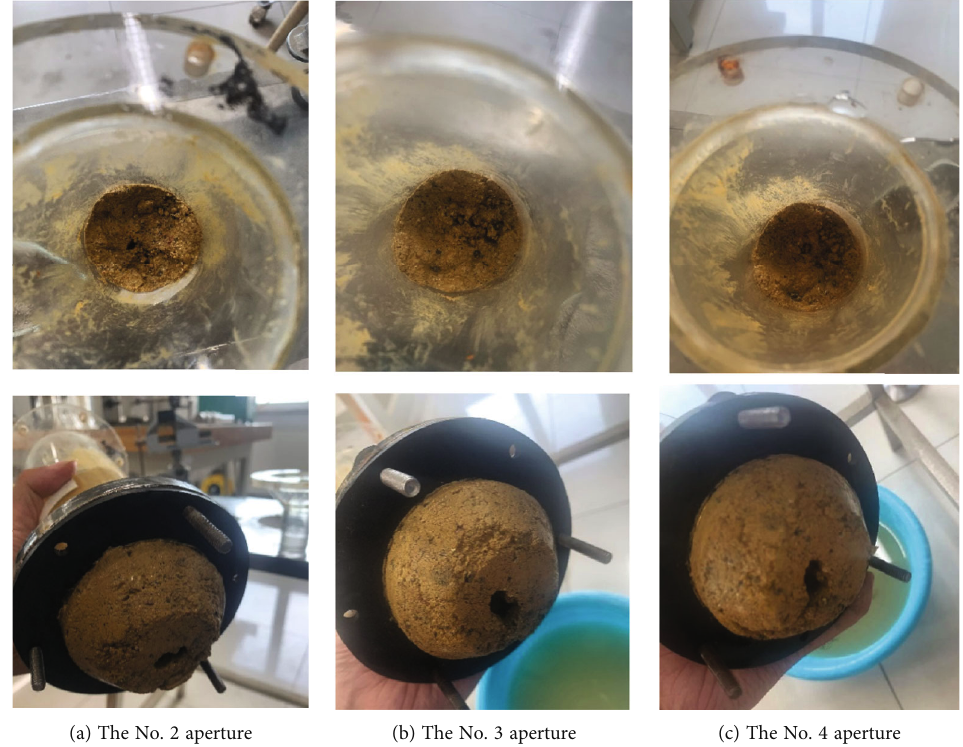
Figure 11: The morphology of the top and bottom of fl ow channel with di ff erent aperture